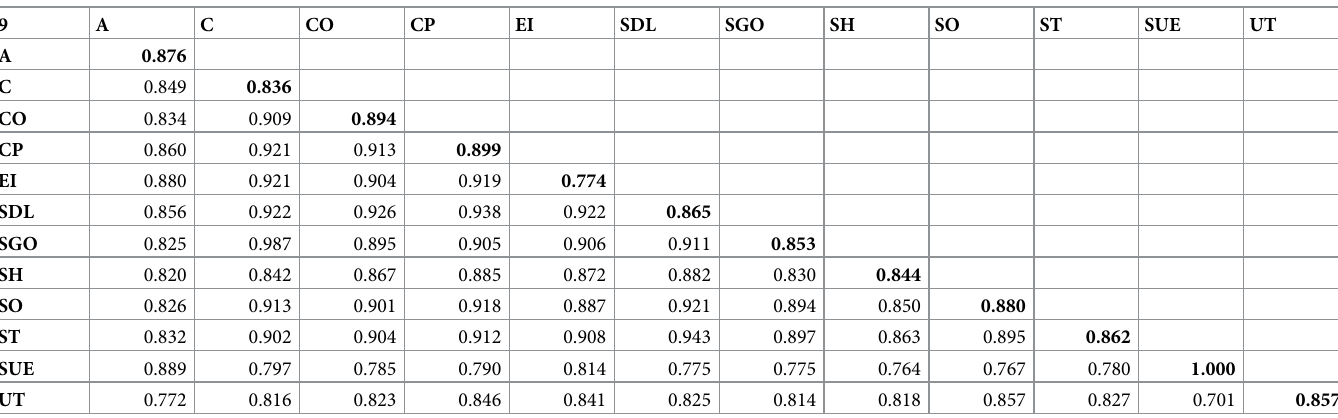
Table 3. Discriminant validity (Fornell and Larcker criterion).